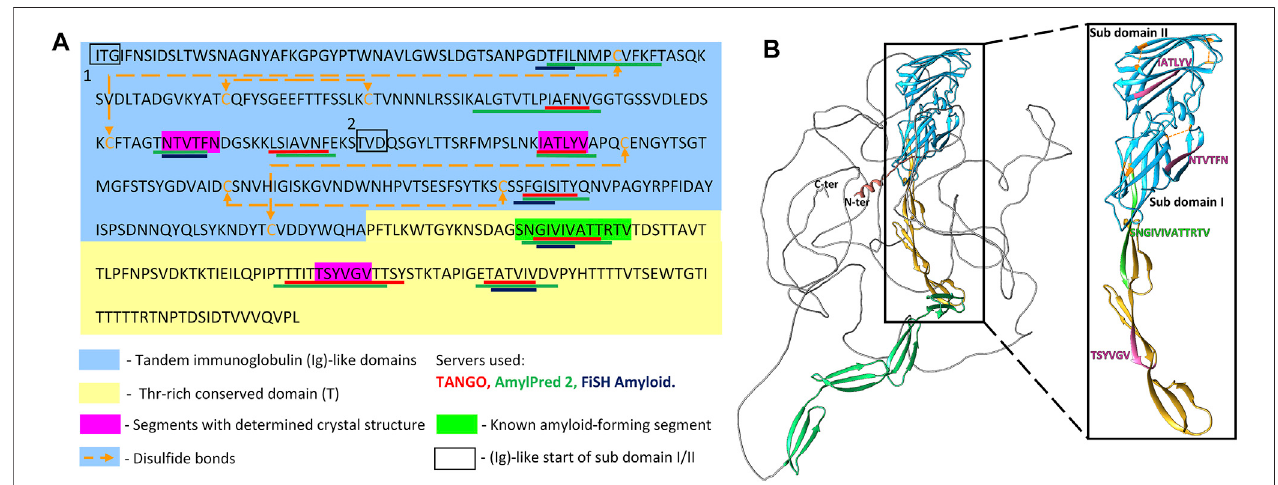
FIGURE 1 | Predicted amyloidogenic segments within Als5 sequence and modeled structure (A) Annotated N-terminal residues 20 – 433 of the Candida albicans Als5 protein containing the Ig-like/invasin and T regions, indicated by blue and yellow backgrounds, respectively. Segments with strong amyloidogenic predictions are denoted with colored bars under the sequence: TANGO (Fernandez-Escamilla et al., 2004) in red, AmylPred 2 (Tsolis et al., 2013) in green, and FiSH Amyloid in blue (Gasior and Kotulska, 2014). Segments for which the crystal structure was determined are marked magenta, and the known amyloid segment 303 SNGIVIVATTRTV 315 is marked green. Disul fi de bonds are illustrated by orange dashed arrow lines. (B) A three-dimensional (3D) model of the Als5 predicted by AlphaFold Monomer v2.0 (Jumper et al., 2021; Varadi et al., 2022).Alphafoldv2 predicted afolded structure for the Ig/T domains (blue and yellow) and four subdomains of the TR region (green), but not for the rest two tandem repeats and the C-terminal 850-residue glycosylated stalk region (grey line). Right inset is an enlarged image of residues 20 – 433 with the two Ig-fold subdomains indicated.